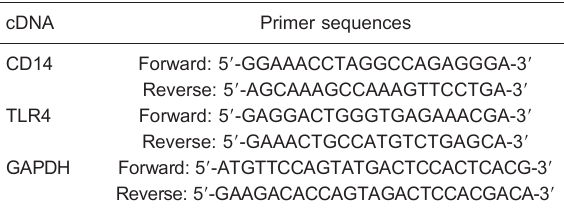
Table 1. PCR primers for RT-PCR.